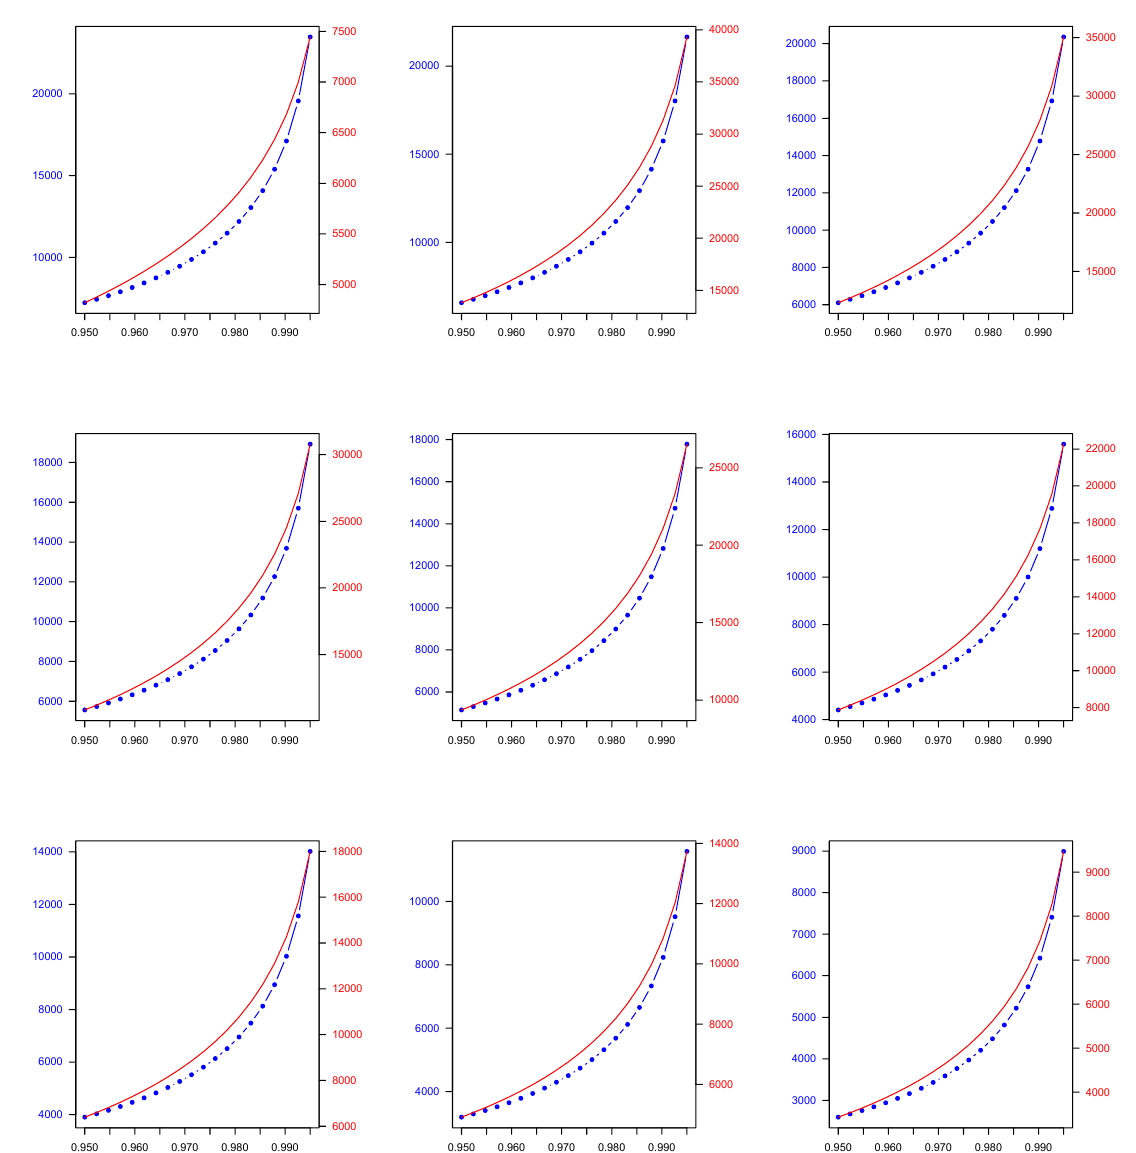
Figure 4. Two-Component (2C) Pareto finite mixture model-based (1 − α ) quantile Q mix . (blue colour) across all ( ˆ π 1 , ˆ π 2 ) combinations versus two-component (2C) Pareto weighted average-based (1 − α ) quantile Q w . a . (red colour) across all ( π 1 , π 2 ) combinations, where (1 − α ) takes values in the range of 0.950-0.995. Note that, due to a considerable discrepancy between Q mix . and Q w . a . values, each given plot has two different y axes—one for each quantile